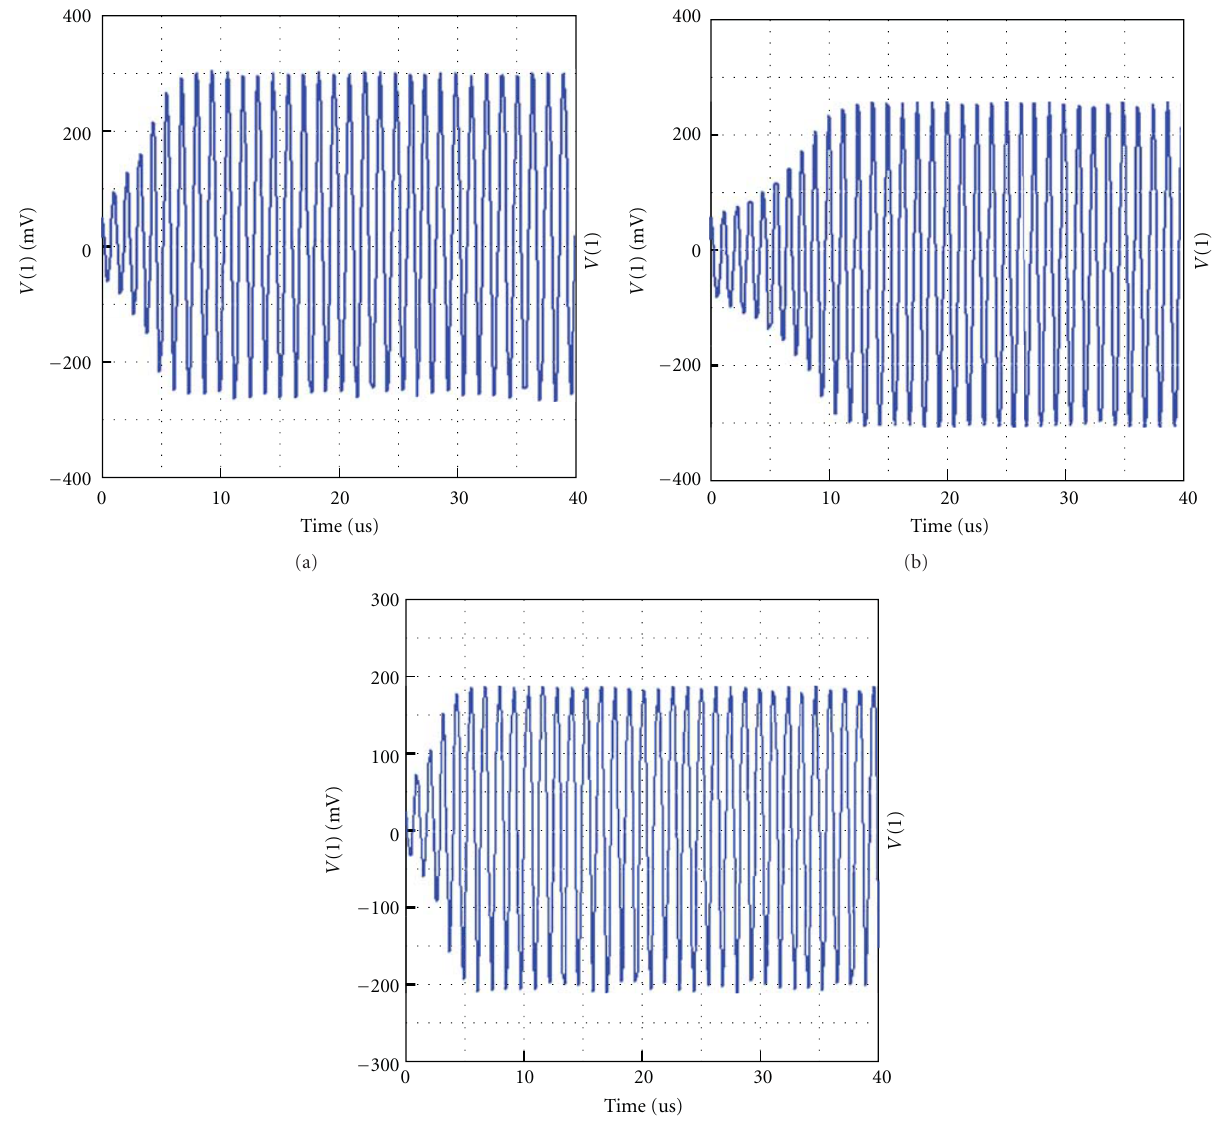
Figure 10: (a) Simulated output waveform of the circuit of Figure 4(b). (b) Simulated output waveform of the circuit of Figure 5(b). (c) Simulated output waveform of the circuit of Figure